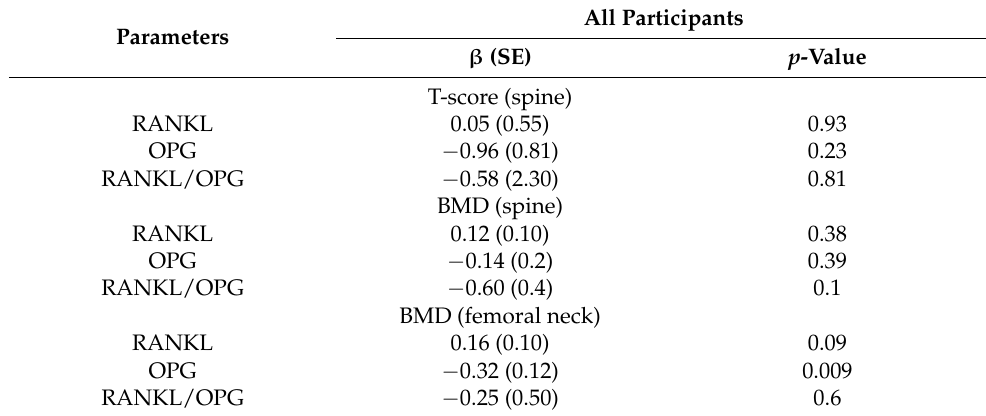
Table 3. Stepwise regression analysis: T-score and BMD as dependent